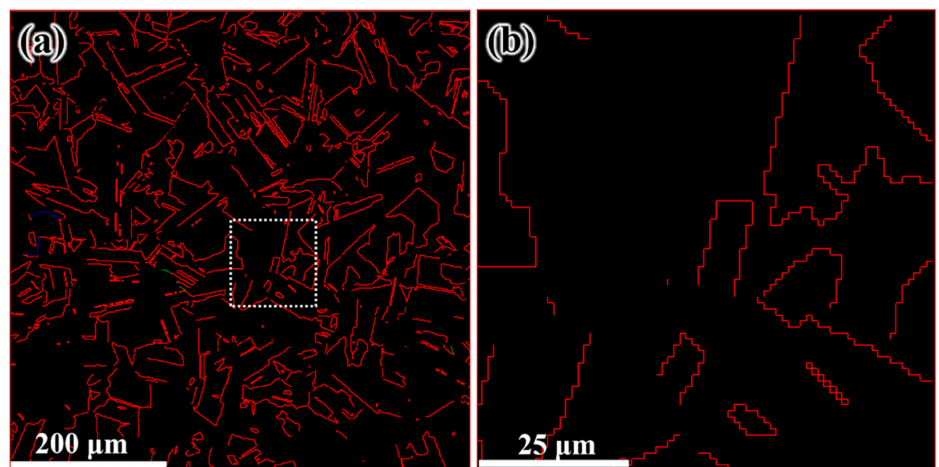
Figure 5. ( a ) The EBSD twin boundary map of initial sample, Σ 3, Σ 5, Σ 7 represent different type of twin boundary and ( b ) zoomed-in image of the region within the box in ( a